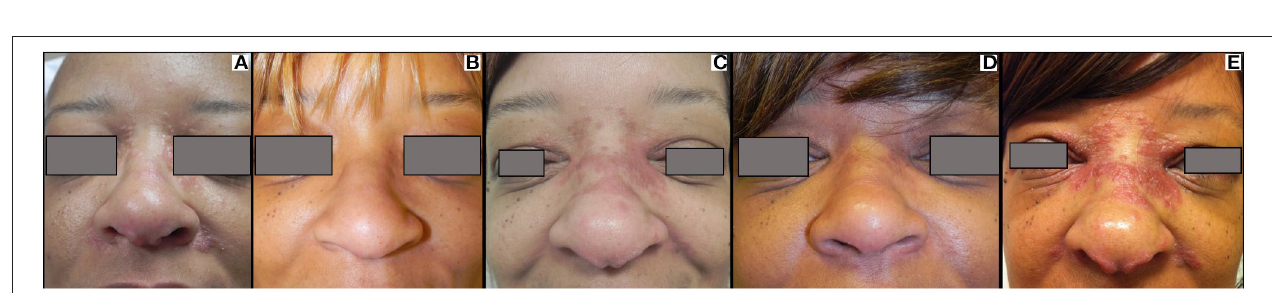
FIGURE 5 | Recurrent cardiac sarcoidosis. These [ 18 F]FDG-PET/CT axial images observed in a 53 year-old male represent findings in recurrent cardiac sarcoidosis. The top row demonstrates FDG-PET images, and the bottom row demonstrates FDG-PET images fused with CT imaging. Foci of increased FDG uptake (blue arrows) are representative findings in recurrent cardiac sarcoidosis present in the mid septal and mid lateral walls (first column), then resolve with therapy (middle column), and then recur in the same location (third column). By column, images are displayed chronologically. The left column captures pre-treatment disease features; these can be compared to imaging features of disease recurrence depicted in the right column (performed 10 months after the initial, pre-treatment scan). Images in the middle column negative scan (performed 5 months after the initial, pre-treatment scan) demonstrate the disappearance of metabolically-manifest disease activity.